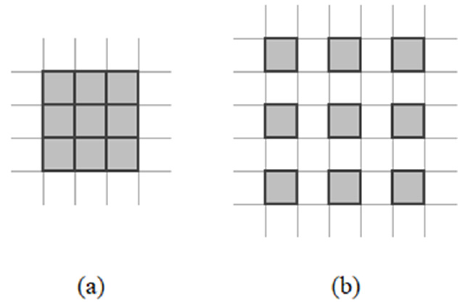
Figure 2. A schematic diagram of the atrous convolution at different expansion rates. ( a ) r = 1; ( b ) r = 2.